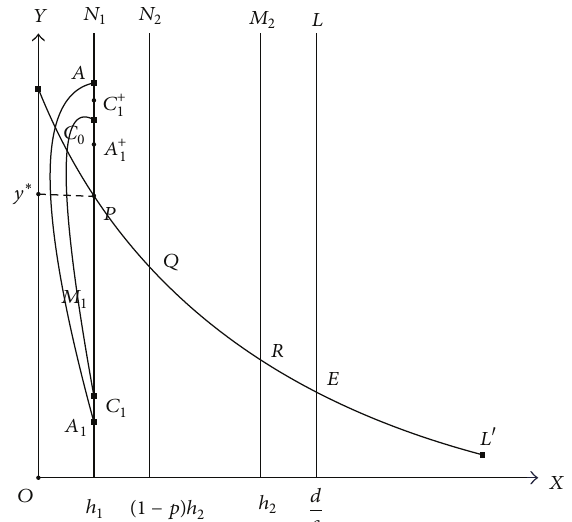
Figure 8: The orbit starting from the point 𝑄 (Case 2 in Section